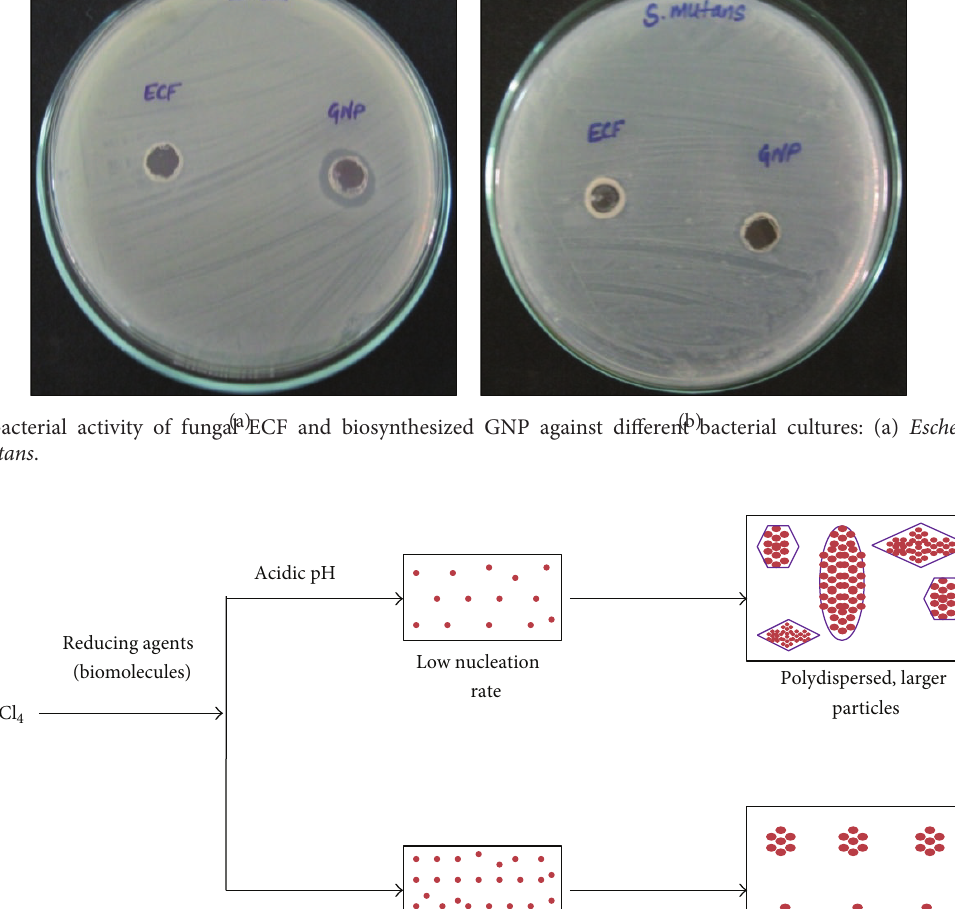
Figure 10: Proposed scheme of GNP synthesis at different pH of fungal